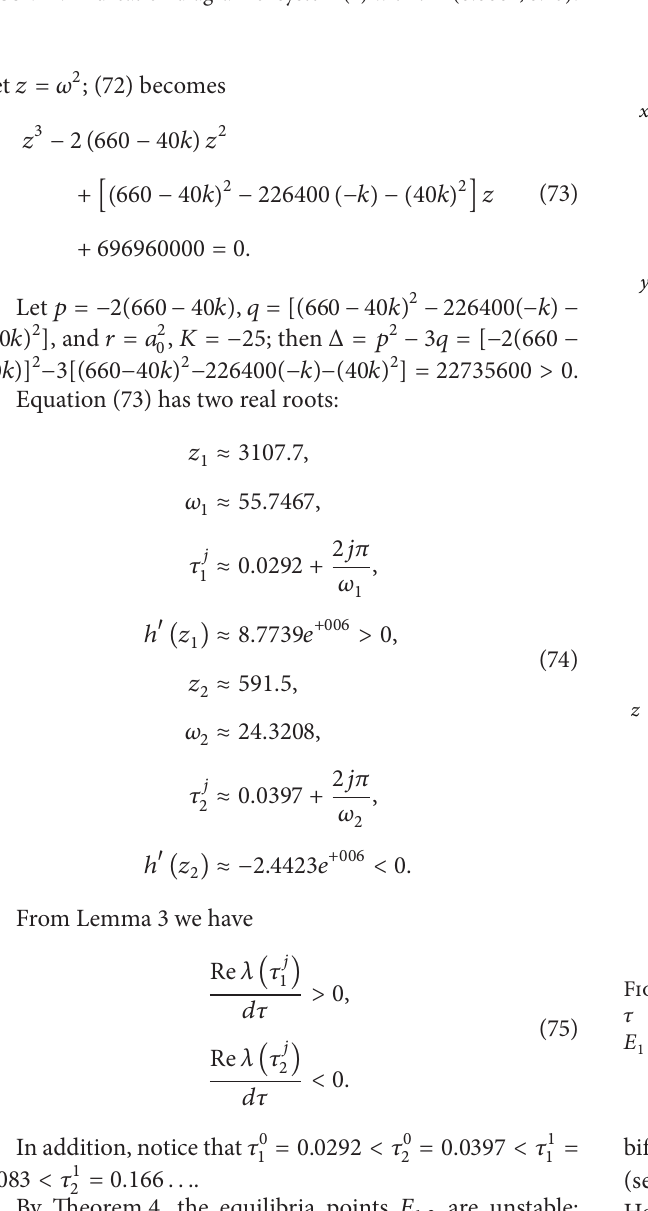
Figure 2: Bifurcation diagram of system (2) with 𝜏 ∈ (0.0001, 0.15) . Figure 3: Local amplification of Figure 2 with